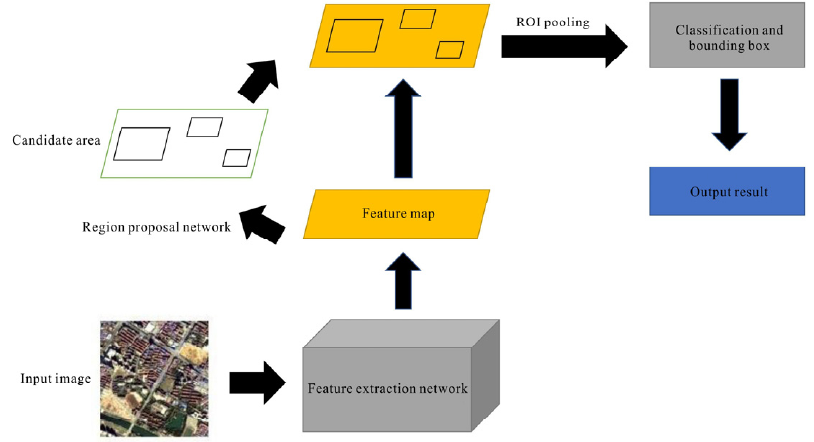
Figure 2. Schematic diagram of Faster RCNN network.